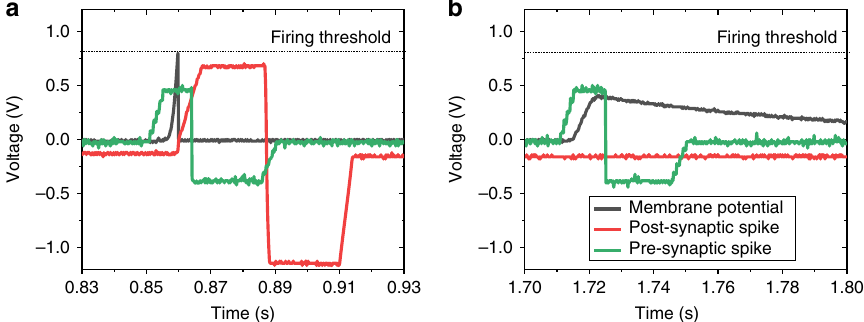
Fig. 3 Signal waveforms. An example of measured oscilloscope signals in the lower-noise pattern coincidence experiment, showing a a pre-synaptic synchronous spike, that along with other synchronous inputs, led to the generation of the postsynaptic spike, and b an out-of-phase pre-synaptic synchronous spike with correspondingly increasing and then gradually leaking membrane